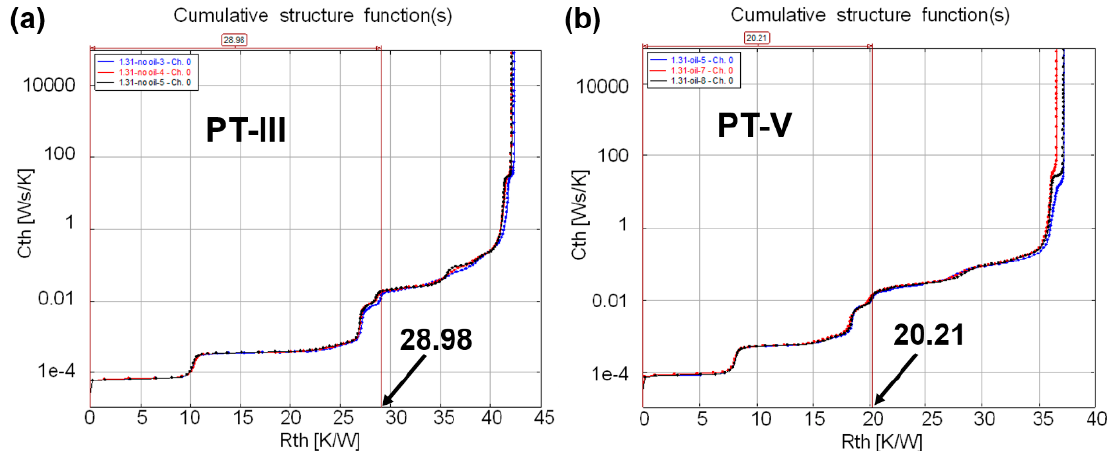
Figure 8. The thermal resistance for 281 nm ( a ) PT-III and ( b ) PT-V DUV-LEDs.